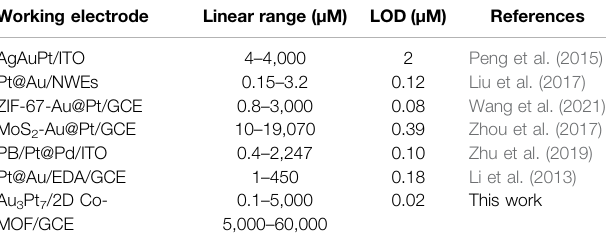
TABLE 1 | Comparison of the different H 2 O 2 sensors in detection performance. Working